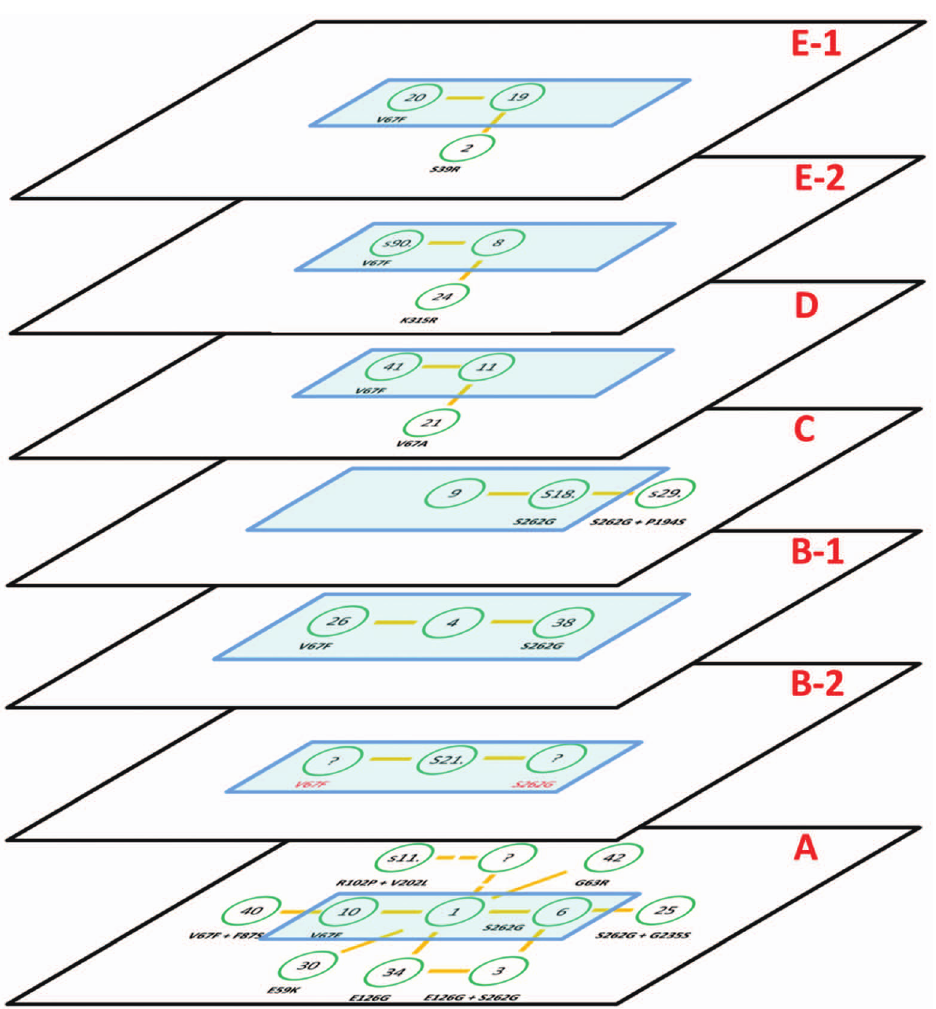
Figure 3. System of 7 networks. Each network is arranged in a separate plane. The core variants (IMP-1, s217, IMP-4, IMP-9, IMP-11, IMP-8, IMP-19) and the variants derived thereof by the mutations V67F or S262G are marked (blue rectangle) and positioned on top of each other.